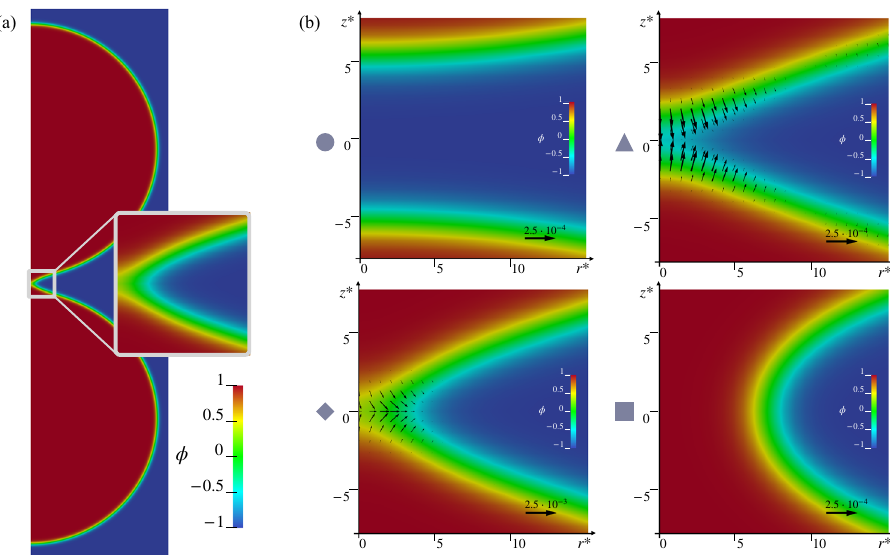
Fig. 6 Close-ups of the merging region. a Full-scale vesicle con fi guration highlighting the merging region enlarged in panel b . b Proceeding in the forward direction: equilibrium of the two bilayers (circle); merging of the proximal interface region (triangle); merging of the distal interface region (rhombus); saddle point con fi guration (square). Considering ℓ pf = ℓ me as described above, the initial distance between the two vesicles is about 3.85 nm. Vectors depict the force fi eld f * required to keep the vesicle in equilibrium in the given con fi guration, balancing the internal elastic reaction. Vectors are scaled according to the reference arrows (note the tenfold increase in the bottom left plot of the comparison with published data, Fig. 5 also provides in blue, with dots, f p = Δ E ( r n )/( r n − r 0 ).